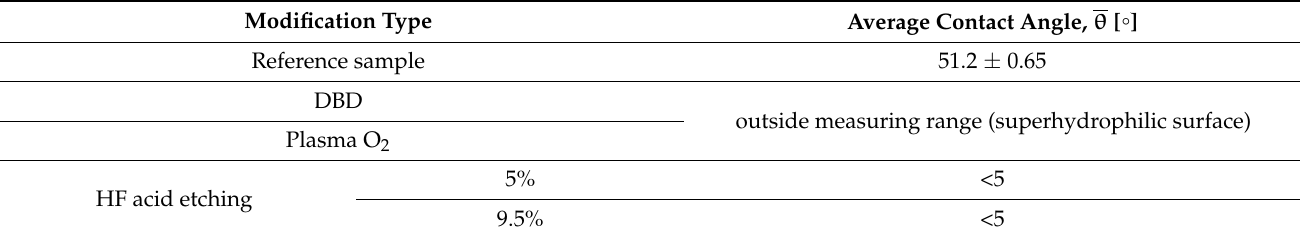
Figure 2. Change in a water droplet shape on the Al 2 O 3 ceramic surface: ( a ) unmodified, ( b ) plasma modification, ( c ) chemical modification. Table 2. Results of wetting angle measurements for distilled water on modified Al 2 O 3 surfaces.